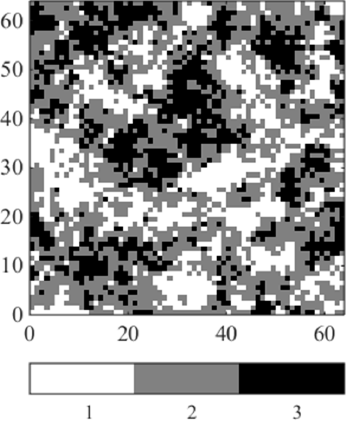
Figure 2. Reference map with dimension 64 × 64 and three categories.